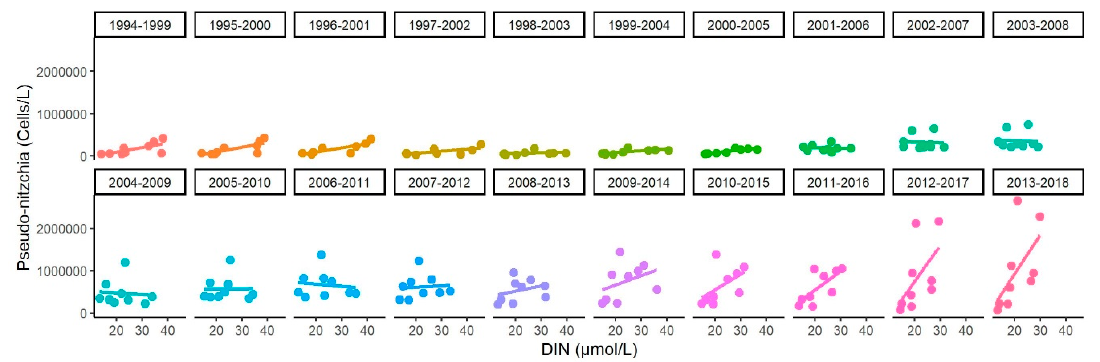
Figure A7. Linear regressions of the relationship between Pseudo-nitzchia and Dissolved Inorganic Nitrogen (DIN) concentrations by period. Input values for both variables are averaged maxima by period, calculated during the growing season for Diatoms and during the winter season for DIN.